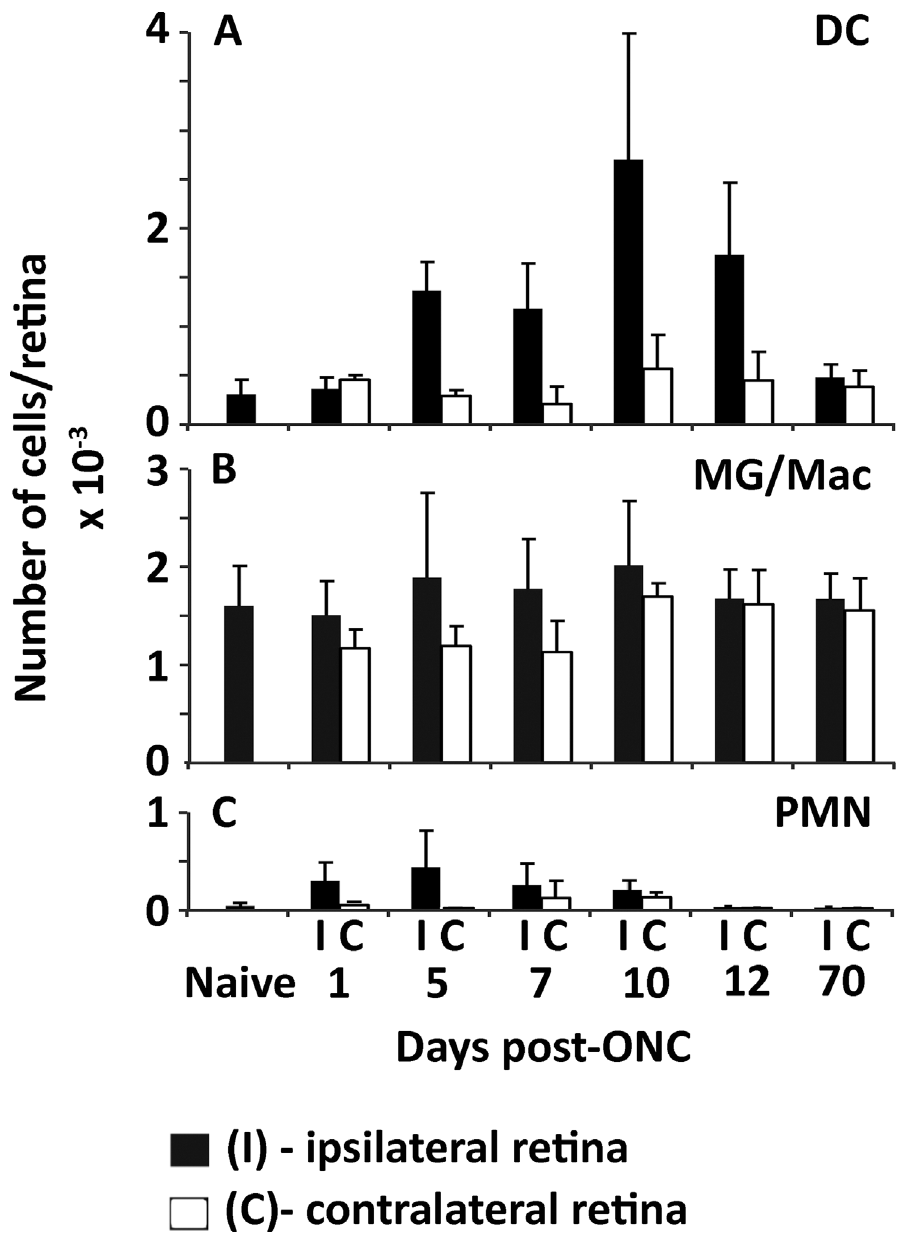
Fig 3. Mononuclear cell response in mouse retina post-ONC. Recruitment of CD45+ cells to retina in CD11c-DTR/GFP mice on the B6 background. Retinas were harvested from naive mice, and from mice at intervals ranging from 1 day to 10 wks post-ONC. ( A ) Dendritic cells (DC) were identified as CD45+CD11b +Ly6G-GFP+. ( B ) Microglia/macrophages (MG/Mac) were identified CD45+CD11b+Ly6G-GFP-. ( C ) Neutrophils (PMN) were CD45+CD11b+Ly6G+GFP-. Other immune cells were present in very small numbers, and not significantly changed by the ONC. Closed bars — ipsilateral (ONC-treated) retinas; open bars — contralateral control retinas. Results are the mean ± S.D. of 4 – 5 mice/group.